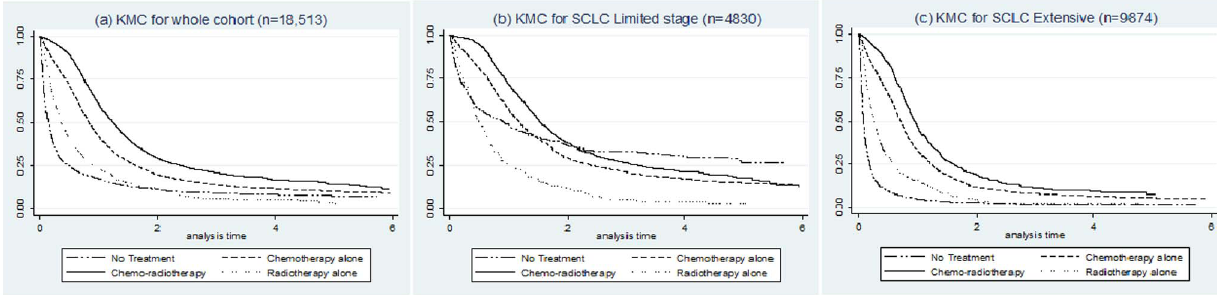
Figure 1. Kaplan-Meier curve estimates adjusted for age, sex, PS and co-morbidity by treatments received: (a) for whole cohort, (b) for SCLC limited and (c) for SCLC Extensive.